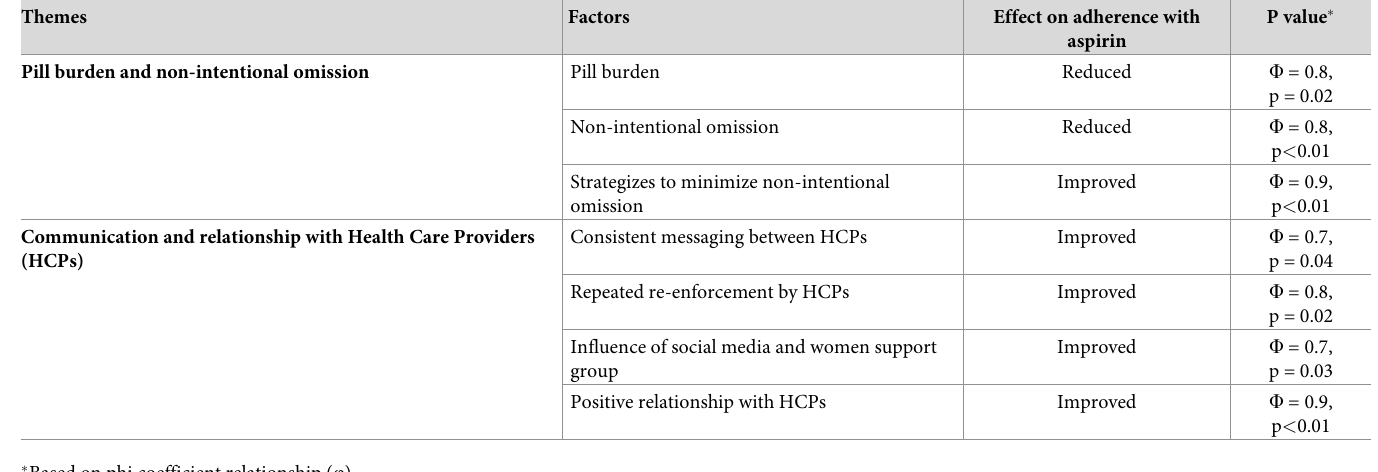
Based on the combined analysis, we identified factors that influenced women’s adherence with aspirin therapy in pregnancy. Results are present thematically: (1) Pill burden and non- intentional omission (2) Communication and relationship with health care providers (HCPs) (Table 3) Pill burden and non-intentional omission: “I had so many pills and aspirin was another pill .. it was a struggle” On average, women in our study were on 3.5 (range 2–6) medications at any one time in their pregnancy with repeated dosing over 24 hours (average: 12 hourly). Of the women who missed Table 3. Summary of factors that influenced adherence with prophylactic aspirin.